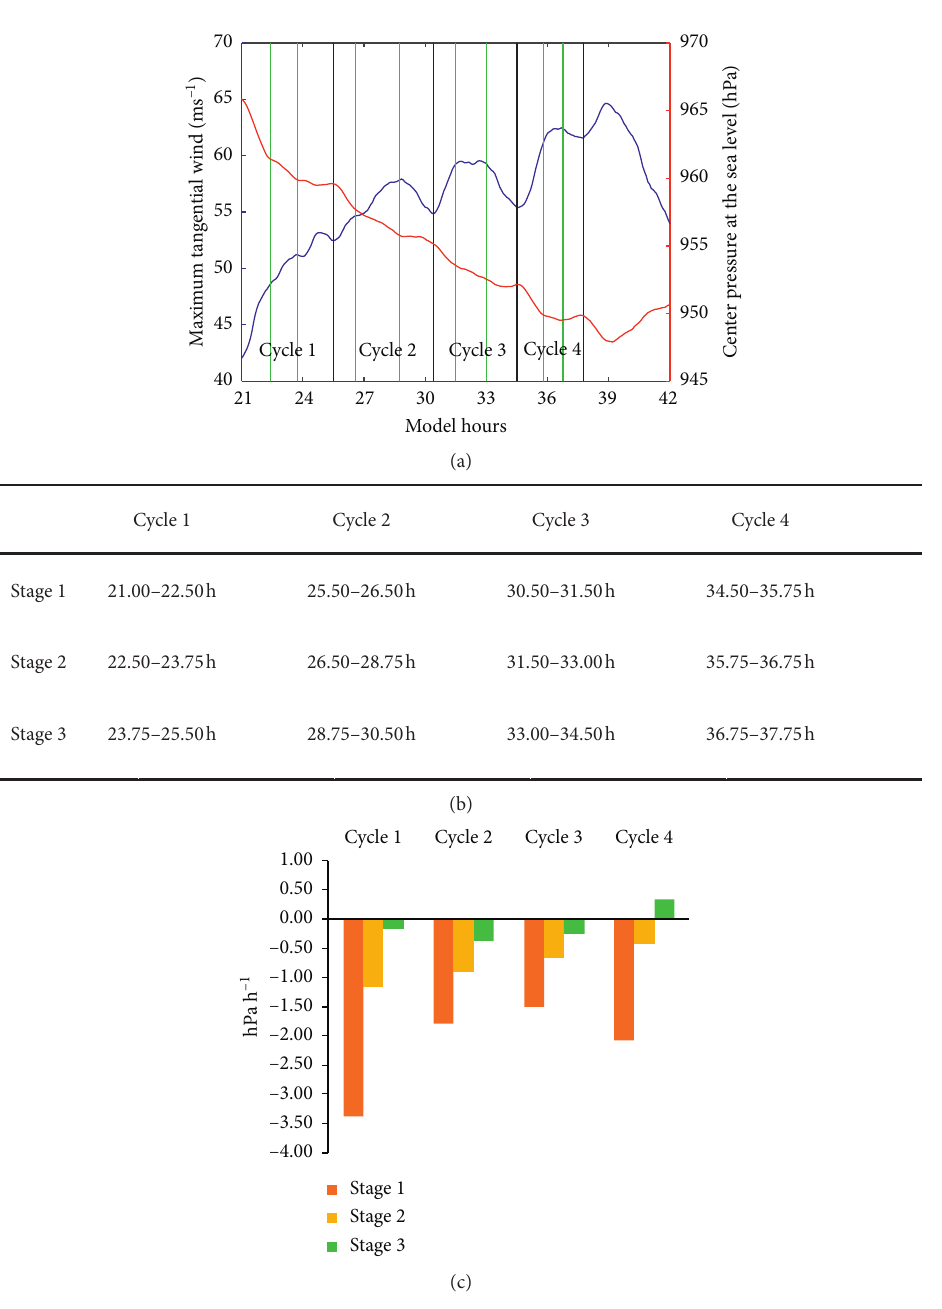
Figure 9: (a) TC intensity as represented by 1 h smoothed maximum tangential wind (unit: m s − 1 ; black line) and average pressure within the eye (radius of 0–20 km) (unit: hPa; red line). The black lines identify different cycles, and the green lines identify different stages. (b) Table showing timing of the stages. (c) Graph showing IR